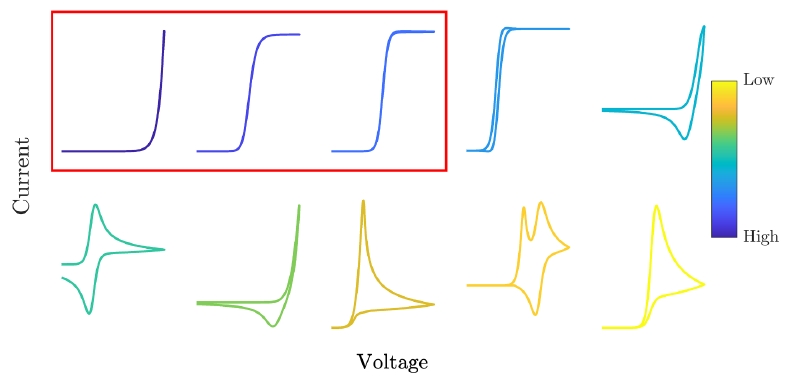
Figure 4. Representative CV curves from the dataset ordered and color coded using the BMS score. CV curves boxed in red will be labeled as targets by the